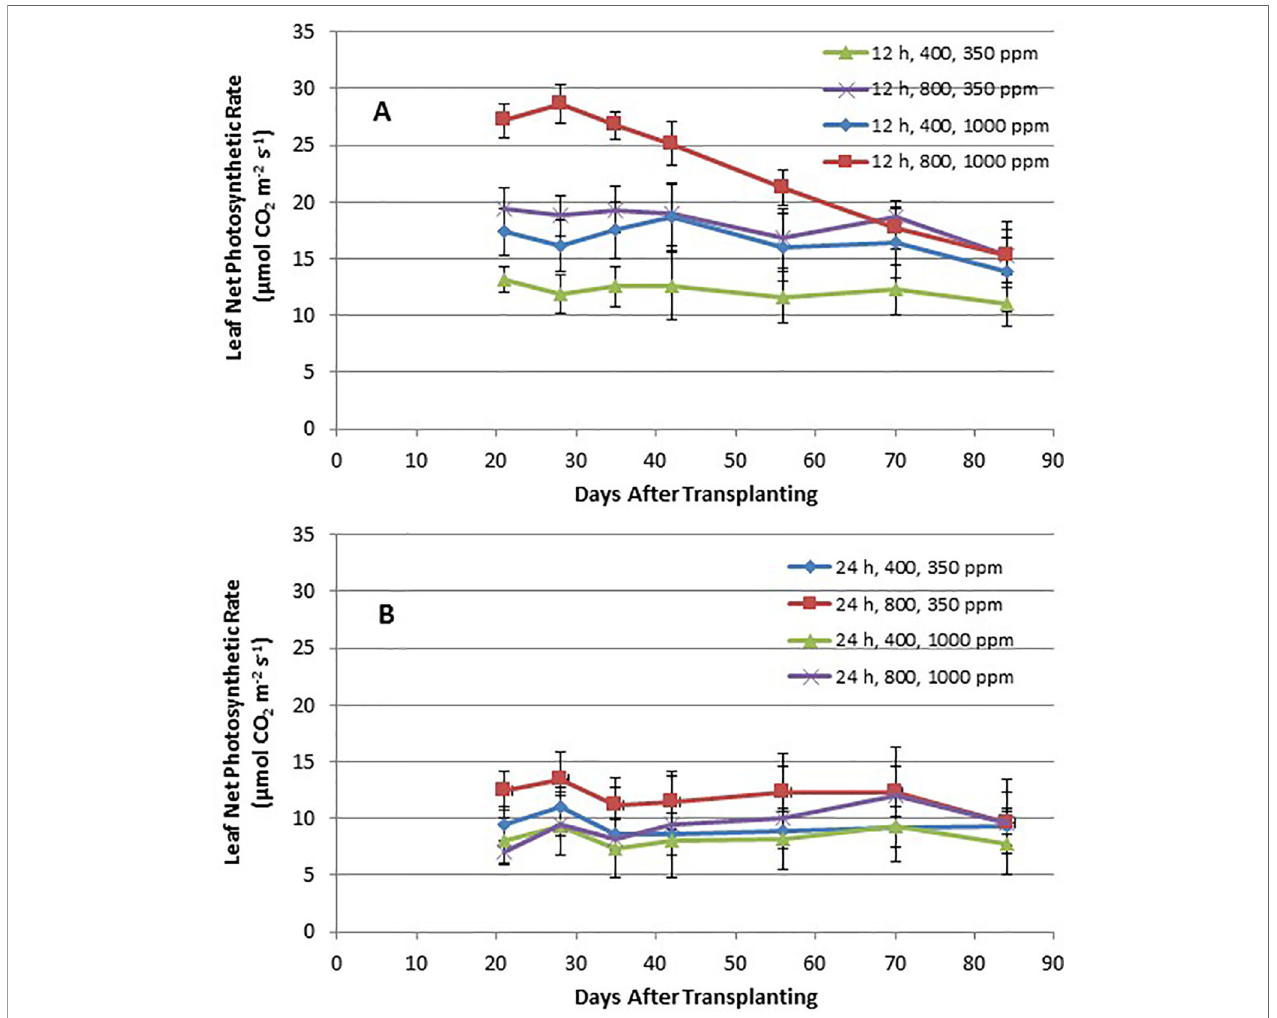
FIGURE 4 | (A and B) . Time course plot of leaf net photosynthetic rates for upper canopy potato leaves grown under different combinations of photoperiod, [CO 2 ], and PPF. Data show combined values of 12 measurements each for cvs. Denali, Russet Burbank, and Norland (total of 36 measurements) for each point. Panel (A) shows data from plants grown under a 12-h light/12-h dark photoperiod, with measurement taken around the middle of the photoperiod. Panel (B) shows data from plants grown under 24-h or continuous light. Standard deviations for each set of 36 measurements (each point) are